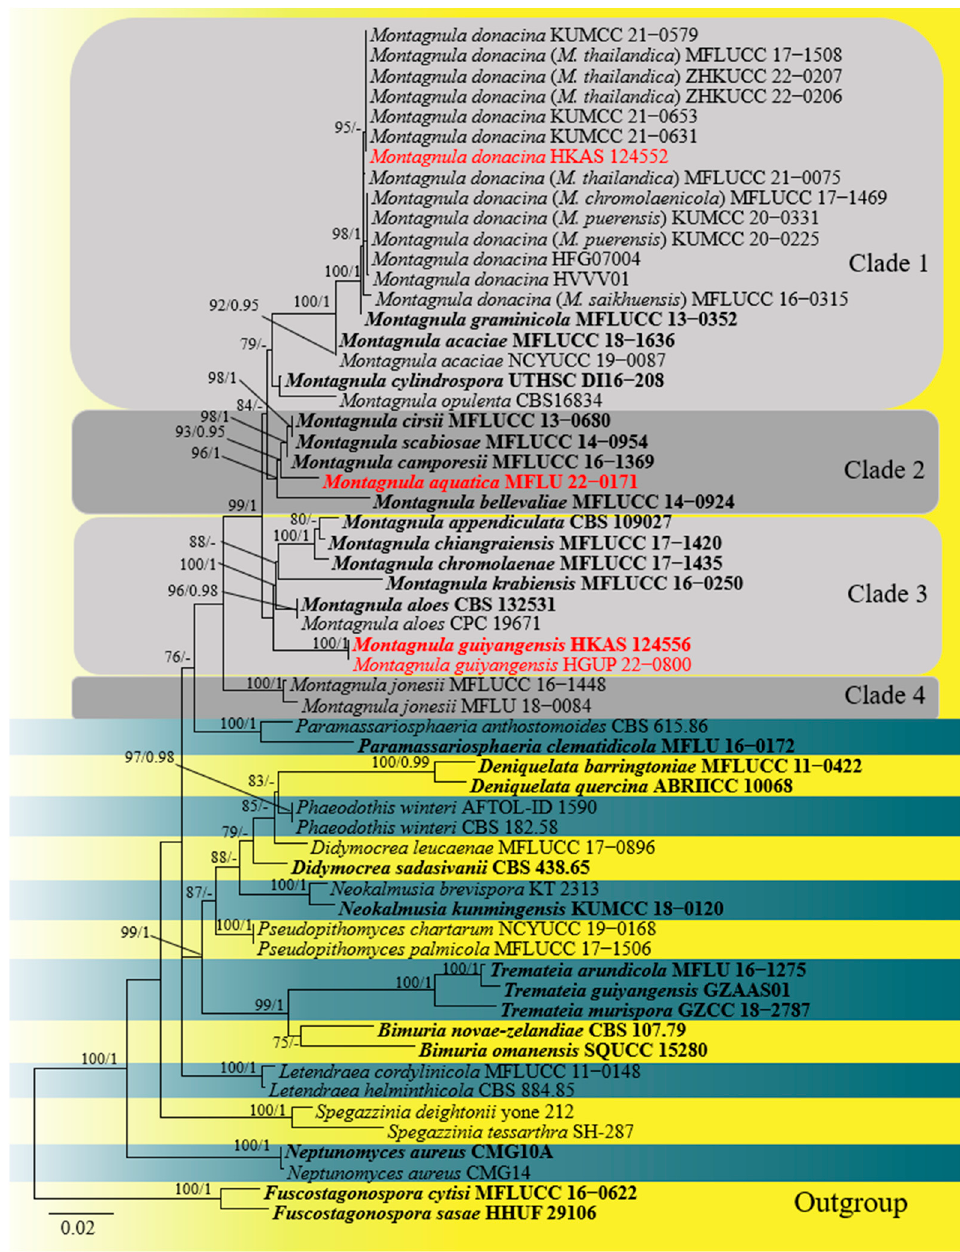
Figure 1. The ML tree based on a combined dataset of LSU, ITS, SSU, and tef1- α sequence data. The tree was rooted with Fuscostagonospora sasae (HHUF 29106) and F. cytisi (MFLUCC 16–0622). Bootstrap support values for ML greater than 75% and Bayesian posterior probabilities greater than 0.95 are given near the nodes, respectively. Ex-type strains are in bold, the new isolates are in red.